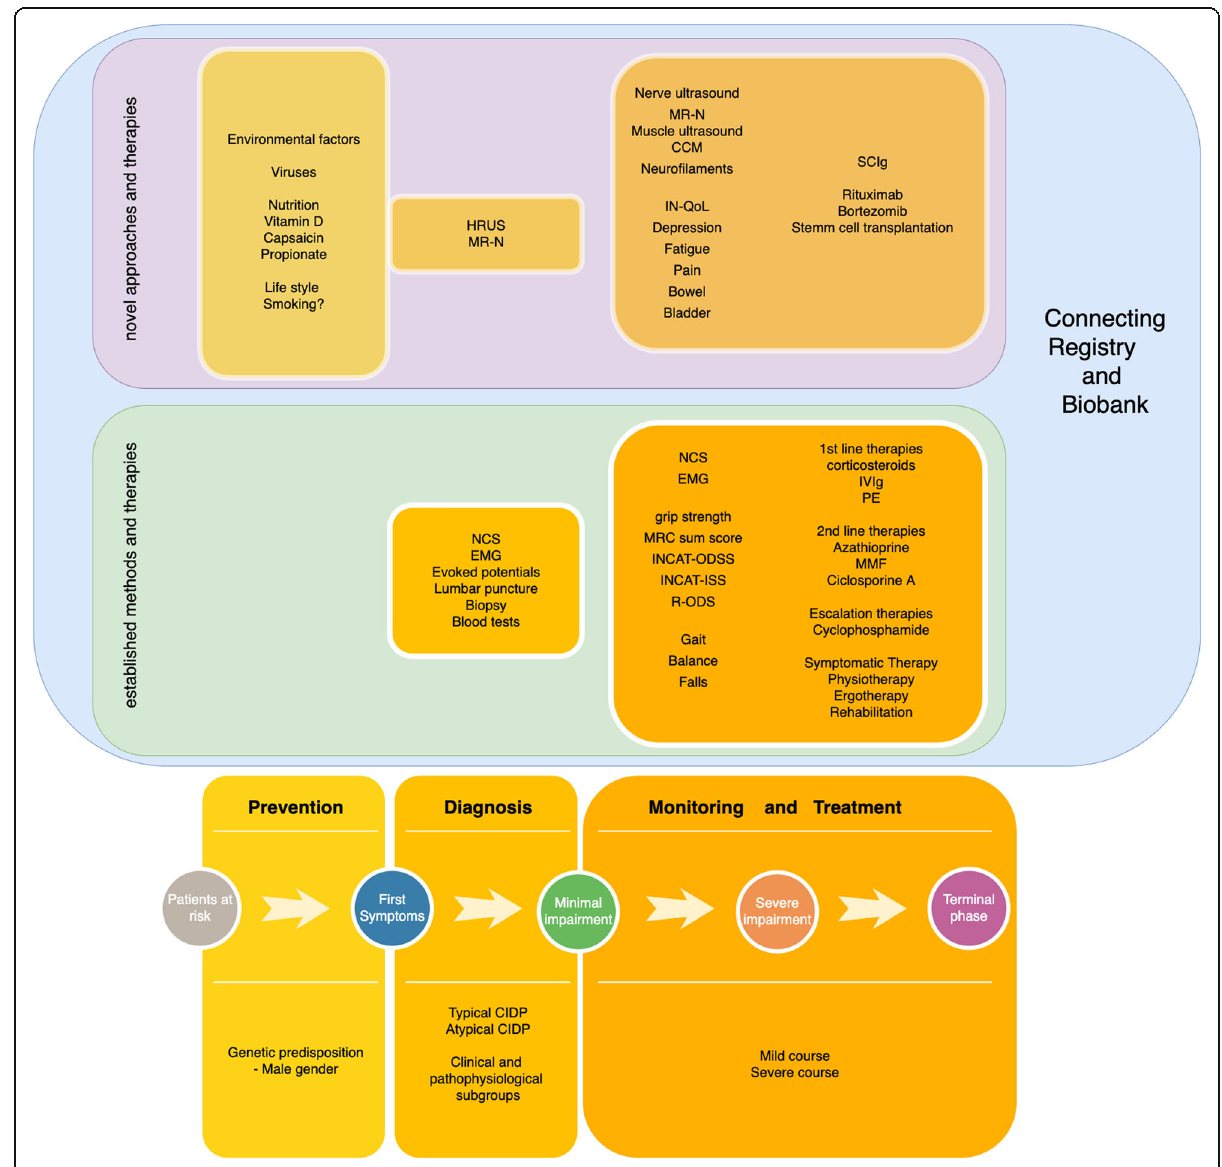
Fig. 4 Overview of comprehensive approaches for diagnosis, monitoring and treatment of